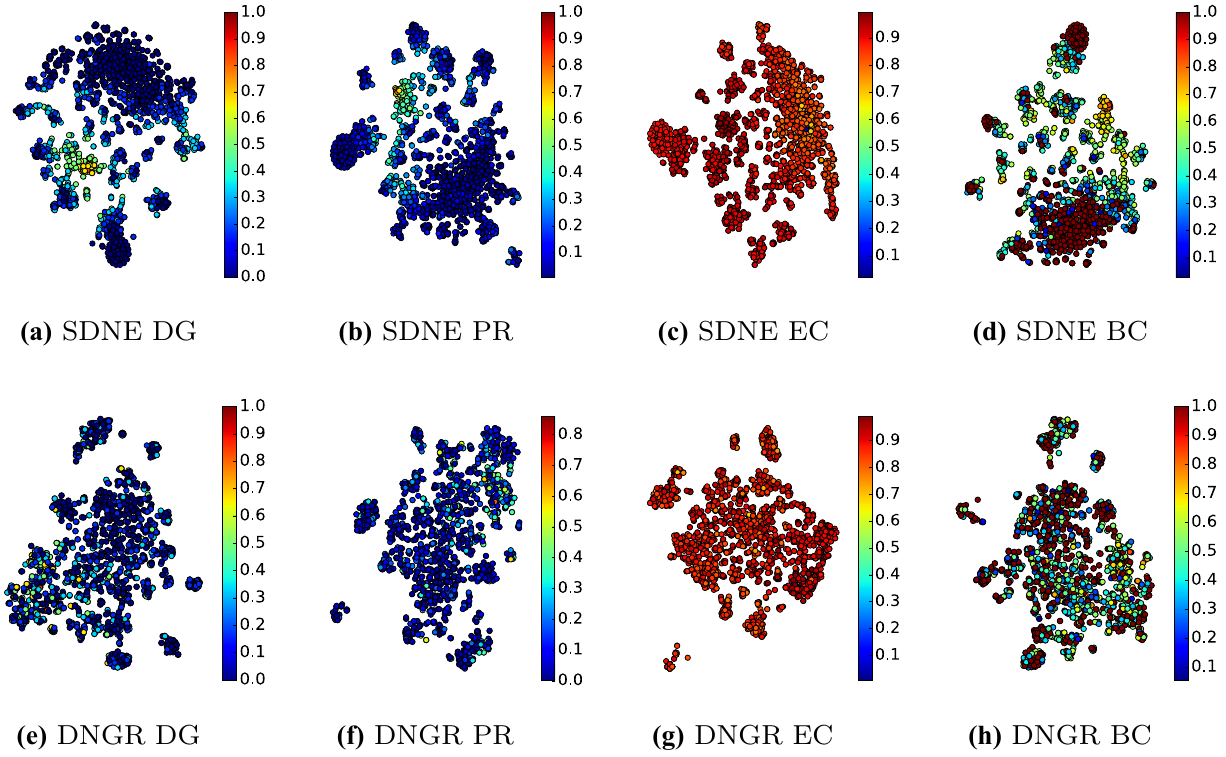
Fig. 11 t-SNE plots of SDNE and DNGR embeddings taken from the soc-sign-bitcoinotc dataset, where points are coloured according to the normalised topological